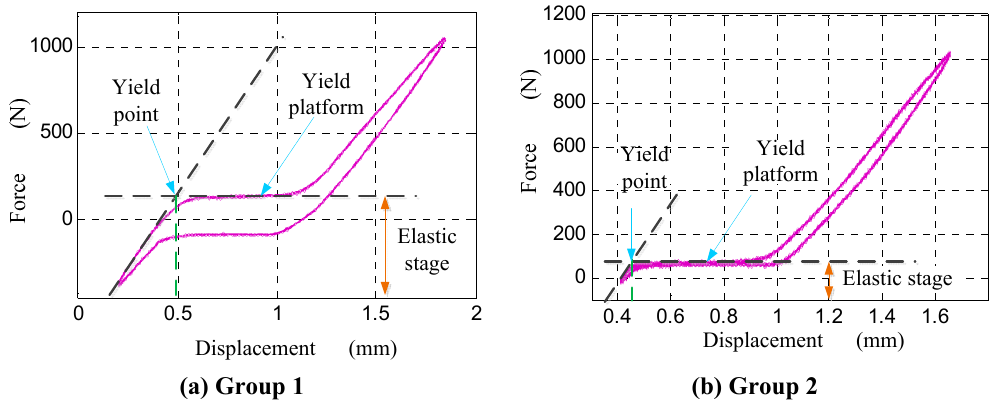
Figure 6. Fatigue yield strength and fatigue elastic modulus.